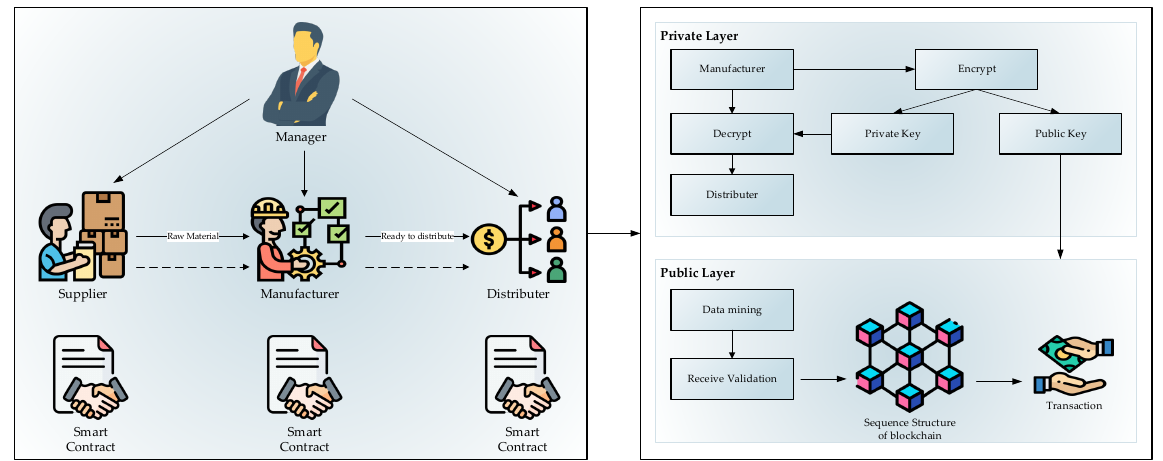
Figure 1. Overview of the proposed